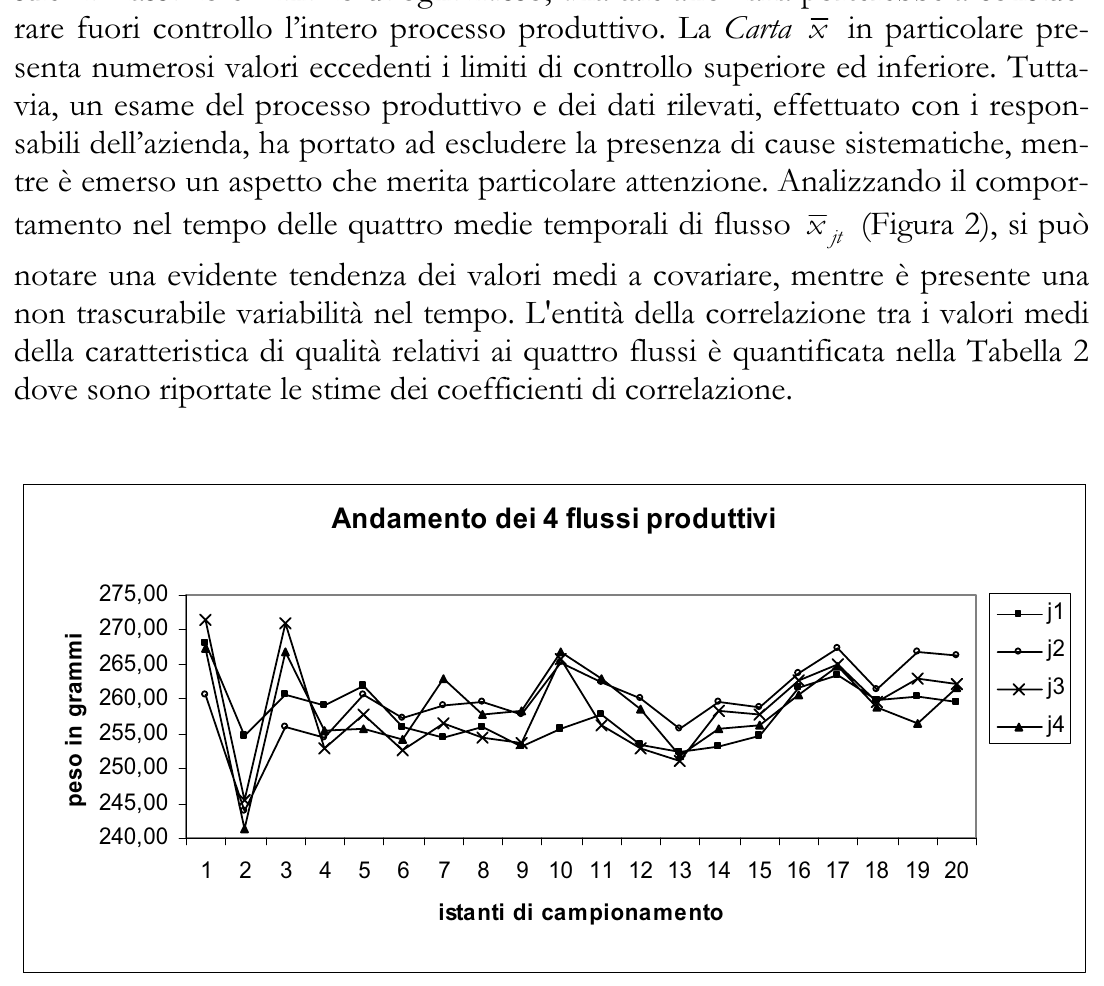
Figura 2 – Serie dei pesi medi campionari dei 4 flussi